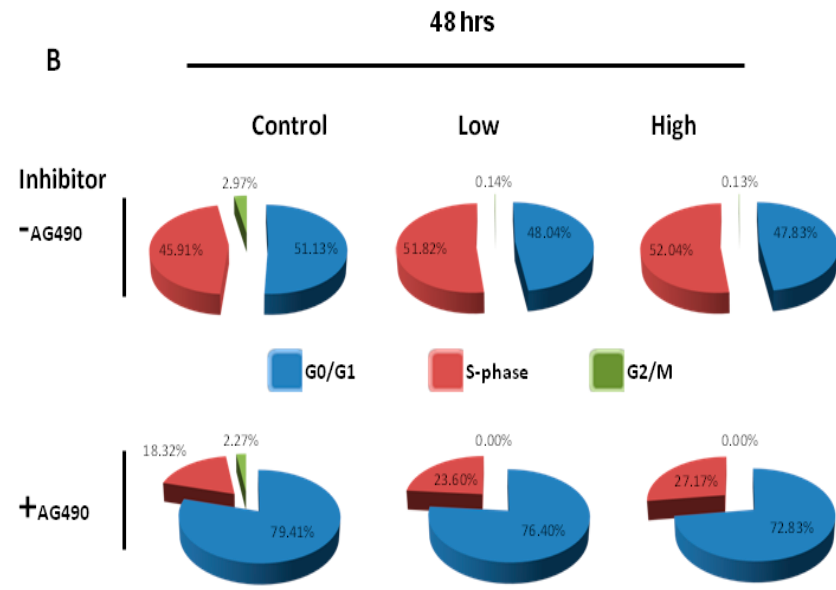
Figure 6. E ff ect of IL-6 concentration and JAK-STAT inhibitor on C2C12 cell cycling at 48 h. ( A ) Flow cytometric analysis of IL6-treated cells, with or without JAK-STAT inhibitor, to determine the e ff ect of IL-6 concentration on C2C12 cell cycling was done after 48 h of incubation. Displayed are representative images ( B ) Summary of data shown in ( A ) of C2C12 cells after treatment with IL-6 and JAK-STAT inhibitor, AG490. The experiment was repeated three times. Results are presented as mean ± standard error of the mean (S.E.M). Statistical analysis: ANOVA and Bonferroni post hoc